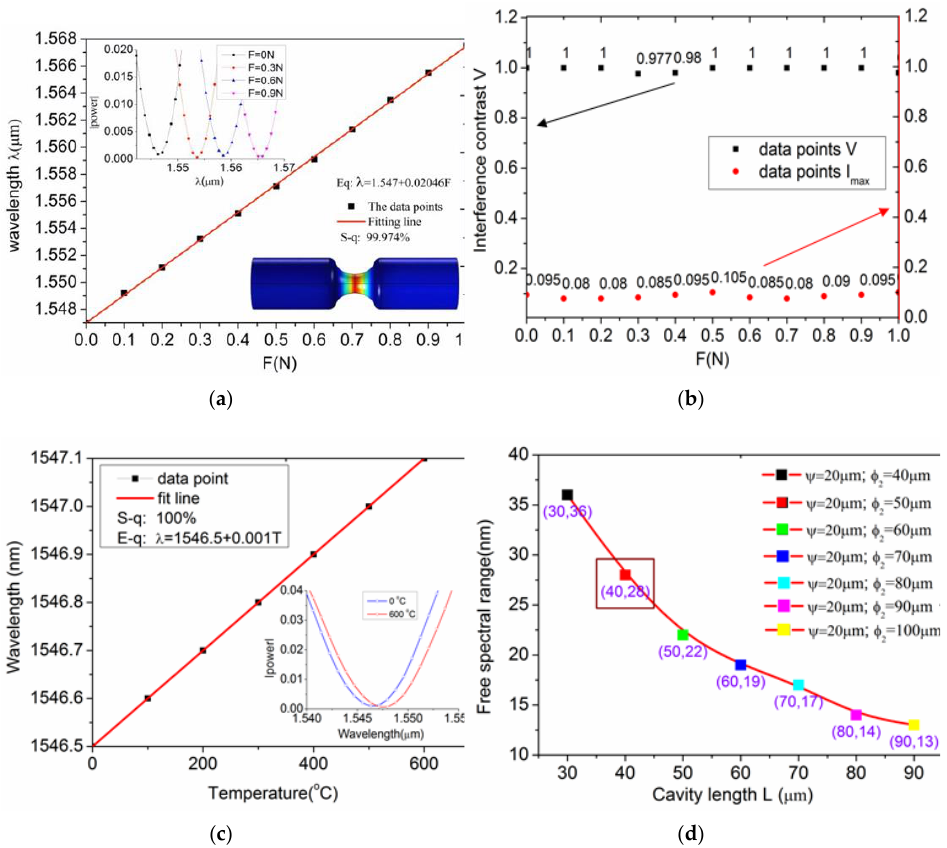
Figure 11. The sensing properties of the hourglass microcavity. ( a ) Strain sensitivity of the hourglass optical microcavity sensor. The inset shows the fringe dip shifts under different axial tension. ( b ) Interference contrast and light intensity reflectivity with different axial tension. ( c ) Temperature sensing properties. The inset is the wavelength shift with different temperature. ( d ) The free spectral range under different cavity length and curvature radius.